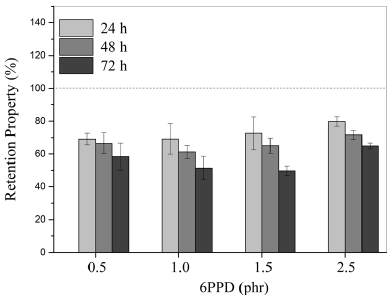
Figure 7. Retention of tear strength for oven thermal-oxidative aging comprising 1.0 phr of TMQ in combination with different 6PPD contents.